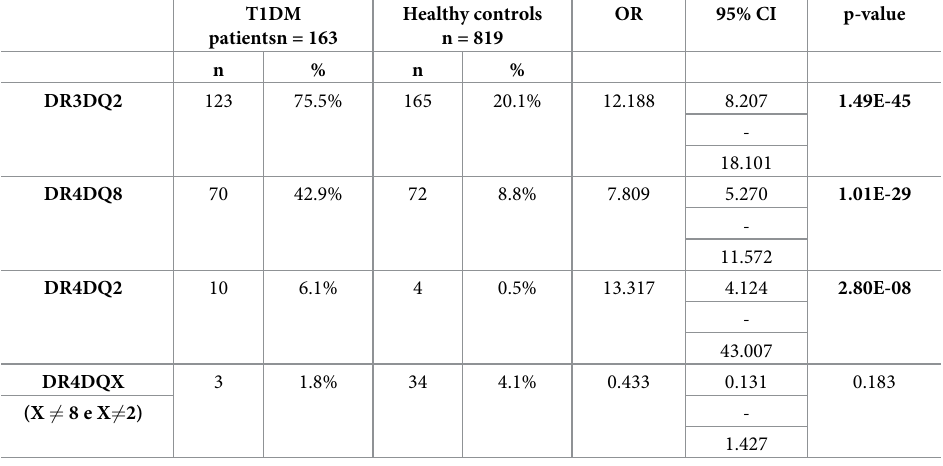
Table 1. Comparison of haplotypes between the population with T1DM and healthy